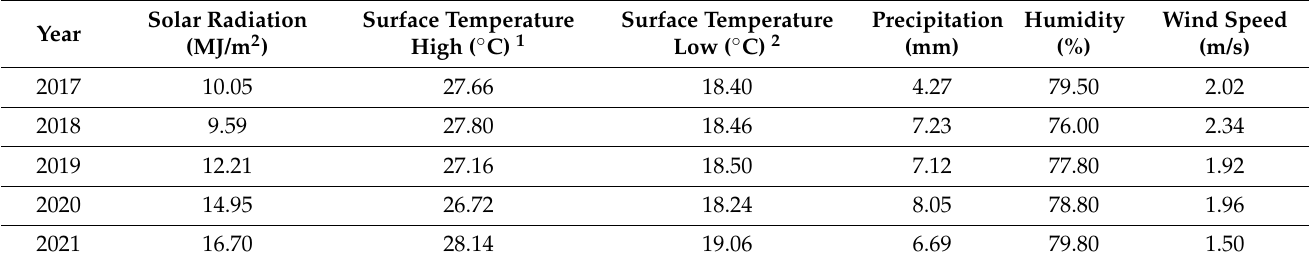
Table 7. Observed climate